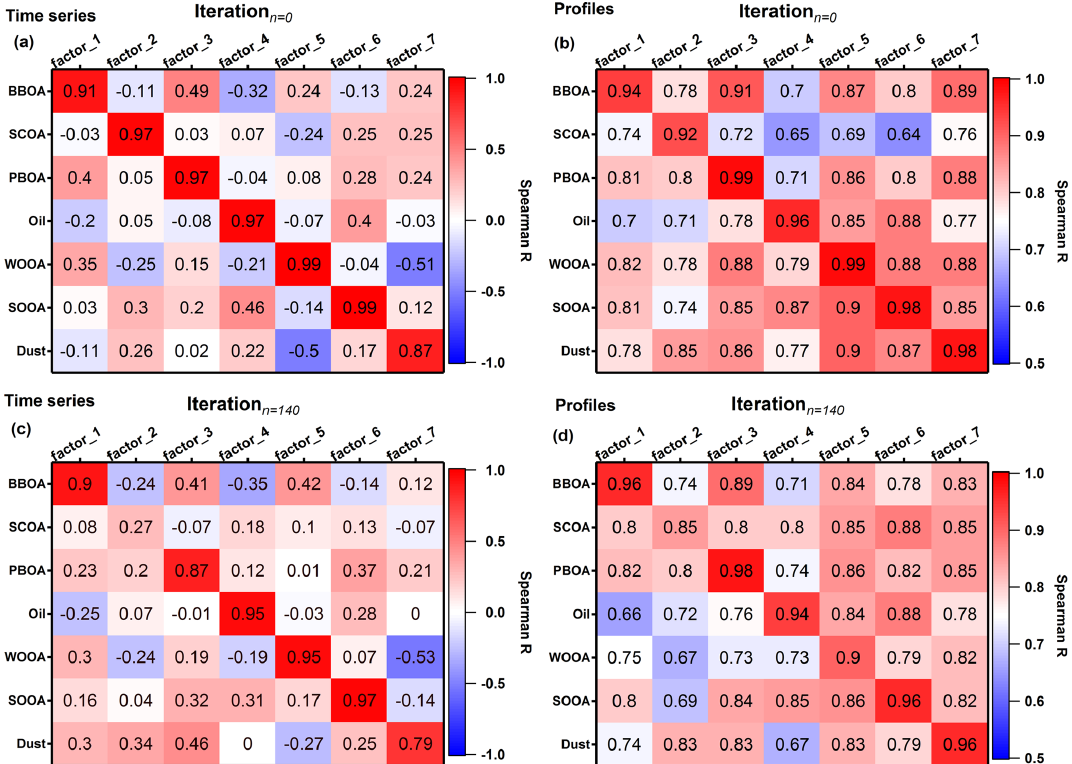
Figure 2. Explanatory tables for the factor sorting based on the time series: (a) accepted bootstrap iteration where all highest correlations ( R s ) lay in the diagonal, and (c) failure to resolve SCOA, as for this bootstrap iteration, both factors 2 and 7 showed the highest correlation with dust factor. The respective tables for the case of profiles are in (b) and (d) . Note the different scales of R s for the profiles.